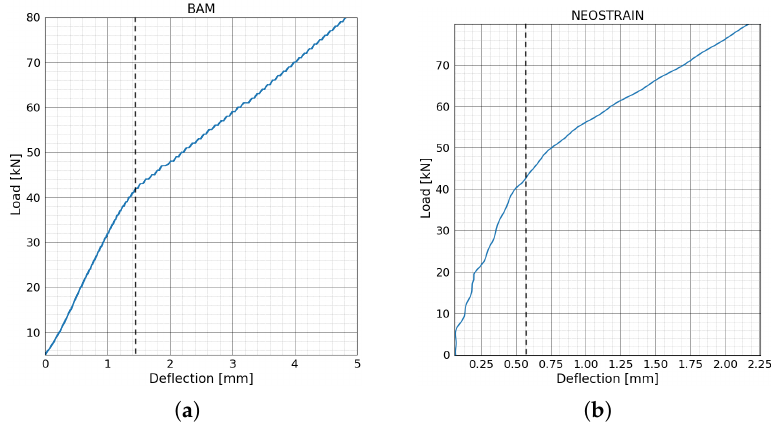
Figure 10. Load-deflection curve for bending test at ( a ) BAM and at ( b ) NEOSTRAIN.